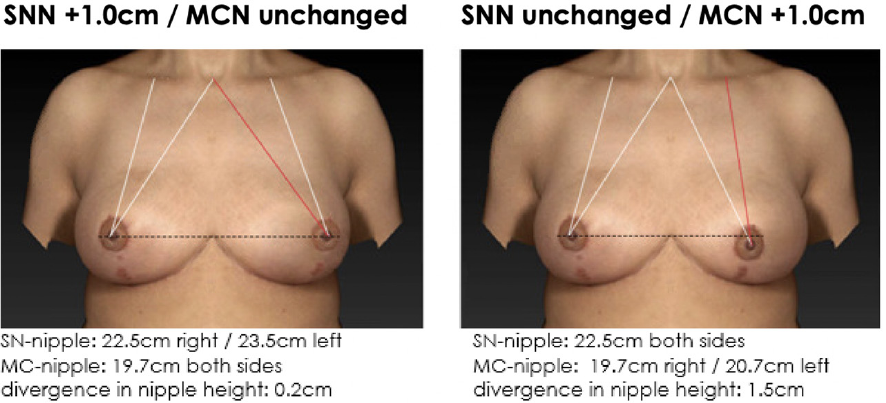
Figure 7. Non-symmetrical mirrored computer-simulated breast models with a modified MC-to- nipple distance and an SSN-to-nipple distance of +1.0 cm. In total, 87% of the plastic surgeons and 79% of the patients find the image with the unaltered MC-to-nipple distance more attractive than the image with the unaltered SSN-to-nipple distance.